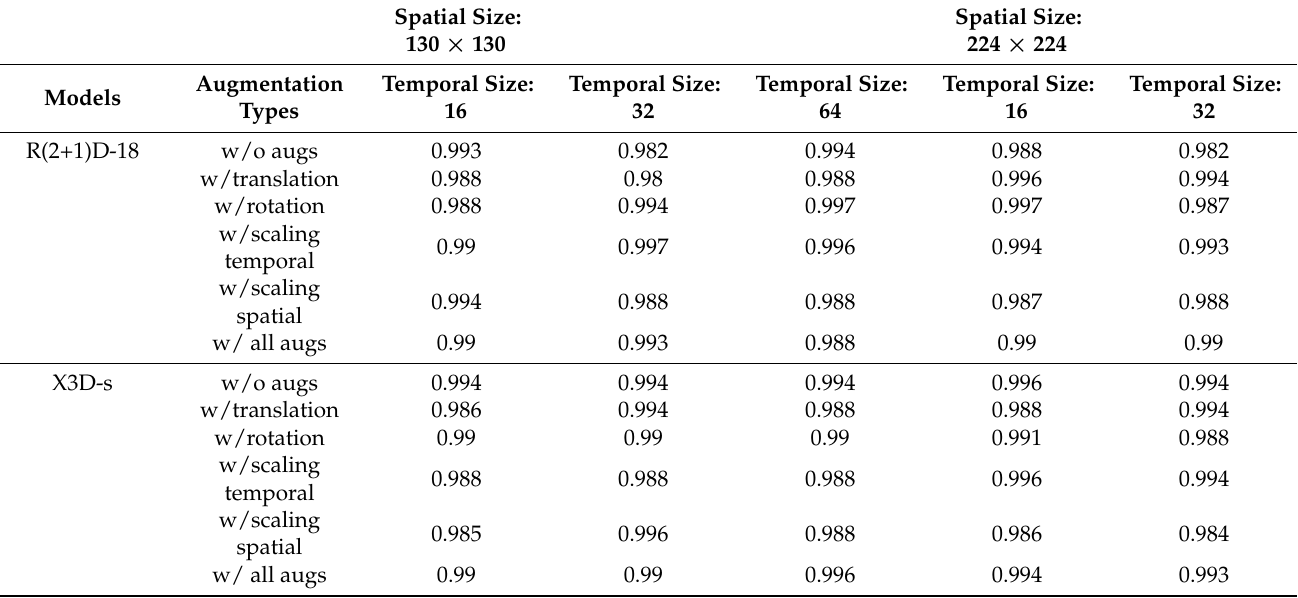
Table 3. Comparison of classification performance across different input sizes, model architectures and different data augmentation